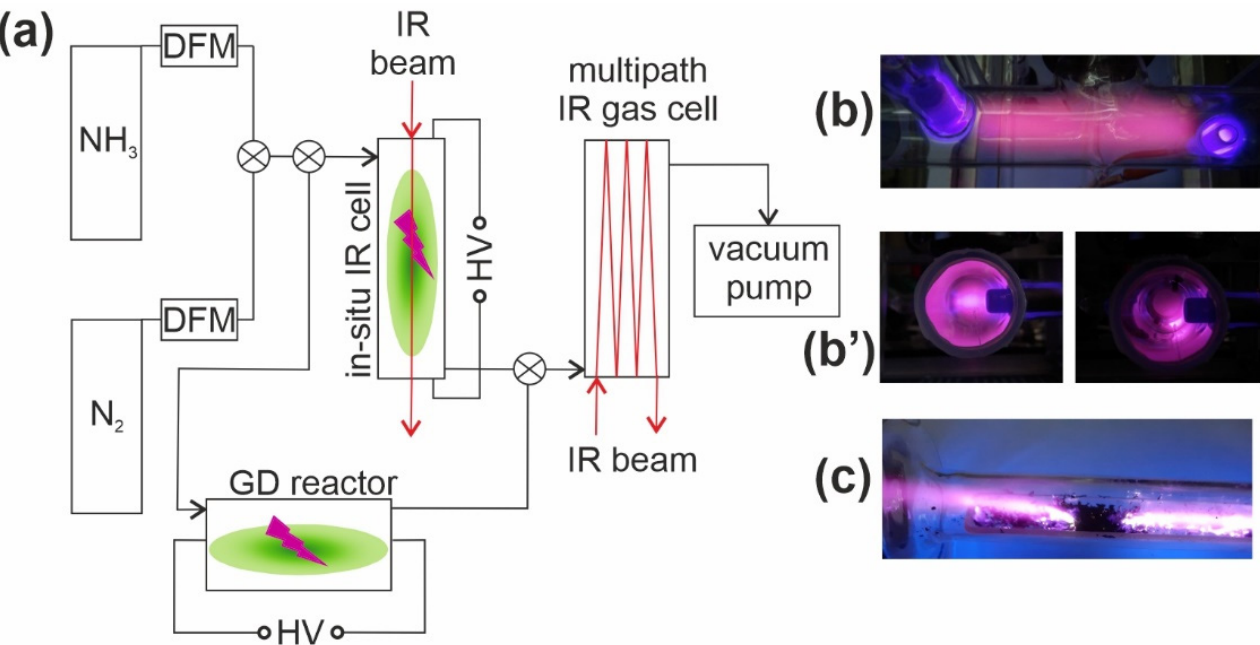
Figure 7. ( a ) scheme of an in situ plasma-assisted catalytic NH 3 conversion system with pictures of working under NTP conditions IR cell ( b ), (note that pictures in ( b’ ) were taken in parallel to IR beam) and glow discharge (GD) reactor ( c ).